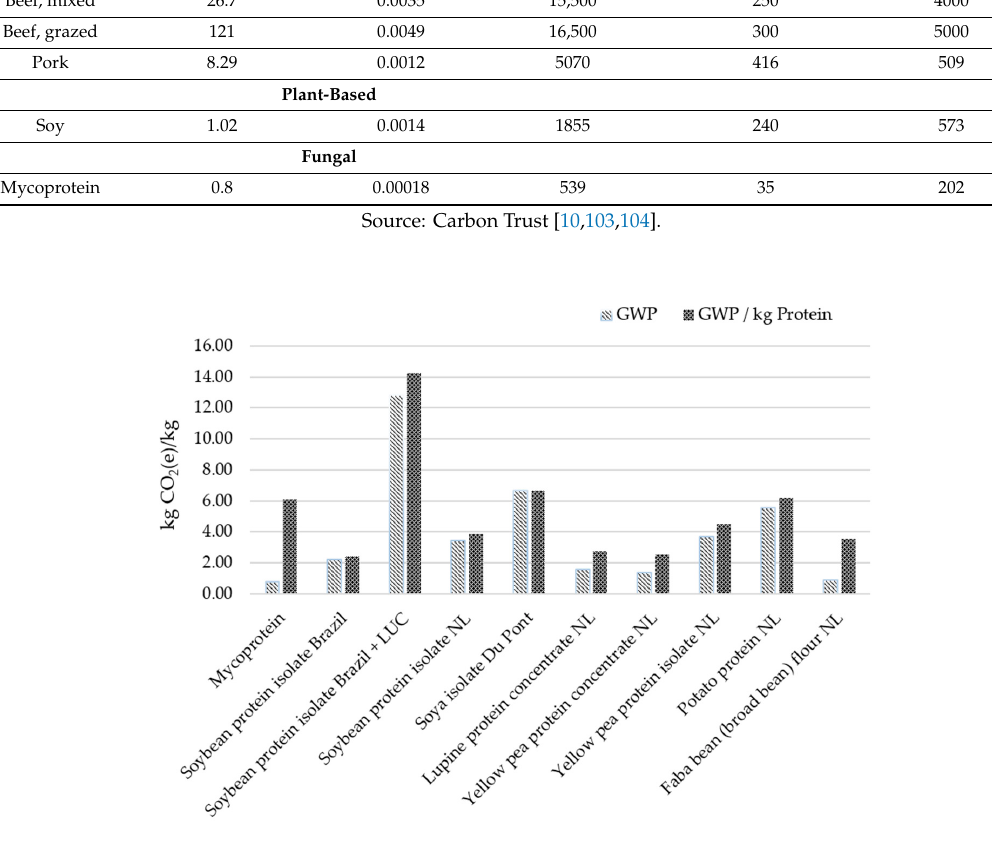
Figure 1. Comparison of mycoprotein global warming potential (GWP) with plant protein. Source: Finnigan et al. (2020) [105].